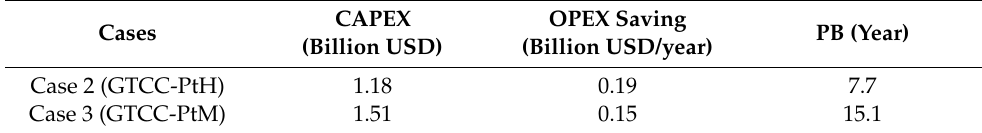
Table 10. Economic analysis results using NG price scenario